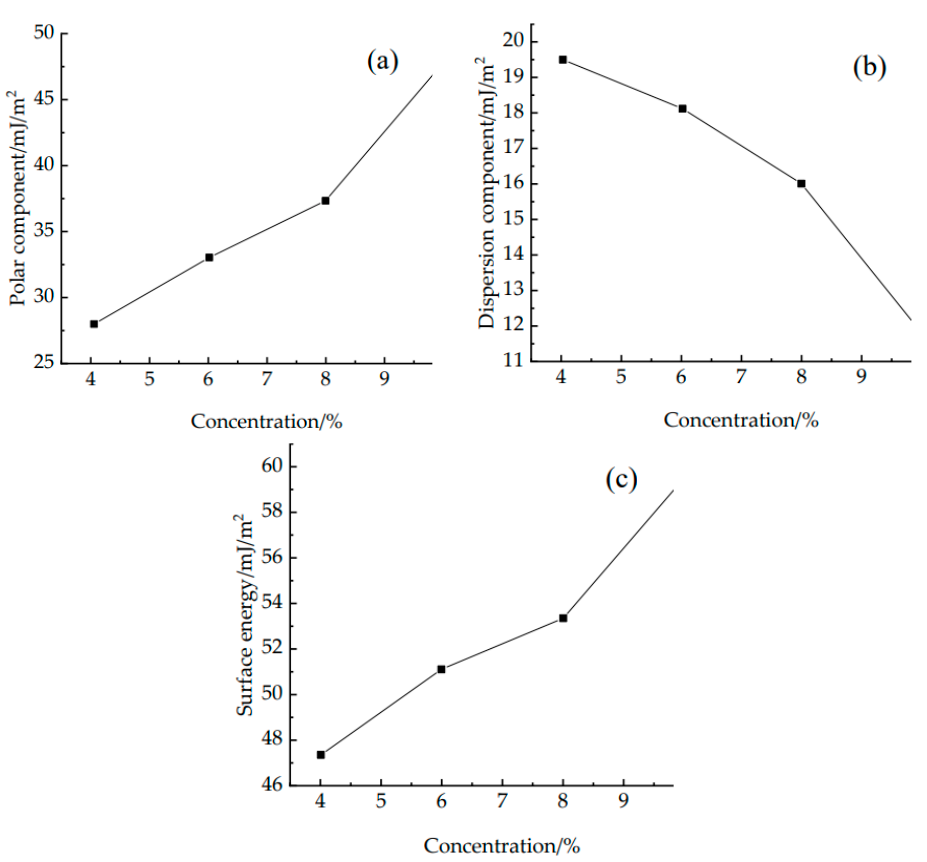
Figure 8. Curves of the surface energy and surface energy parameters with changes in W-OH concentration: ( a ) polar component; ( b ) dispersion component; and ( c ) surface energy.